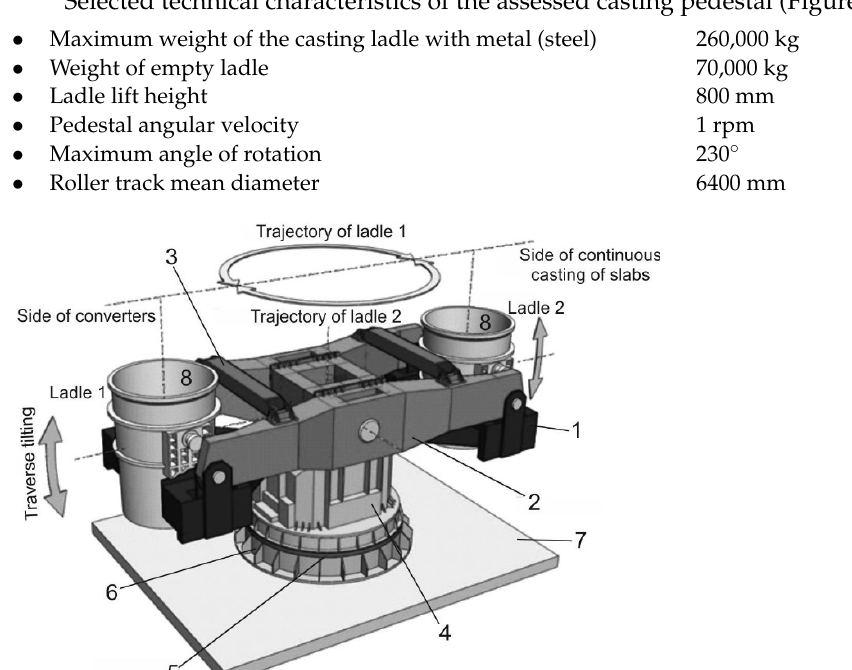
Figure 1. Basic parts of the casting pedestal: 1—hinging supporting baskets; 2—traverse beams; 3— connecting rods; 4—bearing support pedestals; 5—roller bed; 6—supporting structure; 7—concrete foundation; 8—casting ladles.